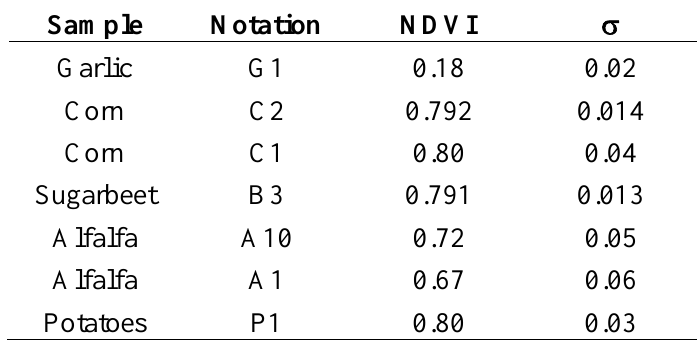
Table 2. Mean NDVI and standard deviation (  ) values extracted from the CHRIS image acquired at near nadir view and using bands 48 (0.852  m) and 25 (0.674  m). Values were extracted for the whole plots associated to the different